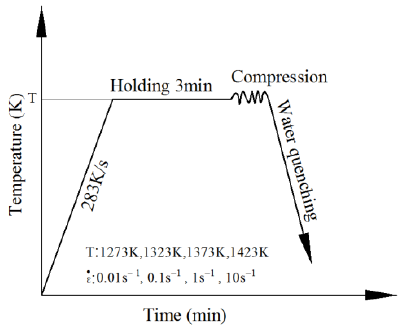
Figure 1. Experimental procedure for measuring the experimental stress–strain curve of 30CrMoA.